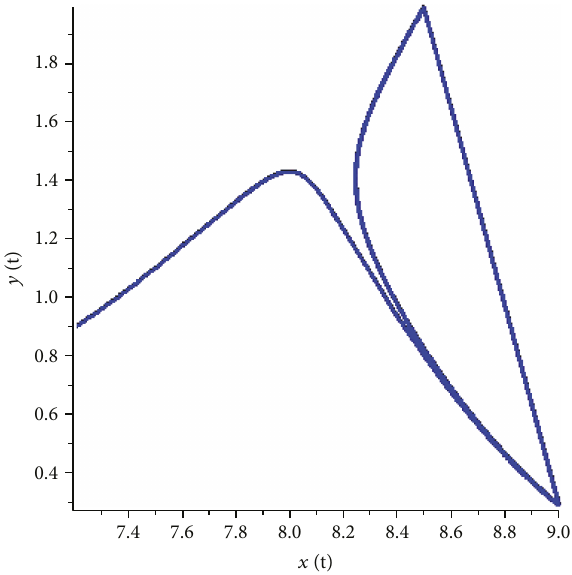
Figure 23: There exists an order-1 periodic solution in system (16) with q 1 = 1/18 , p = 0 8 , and τ = 1 7 .